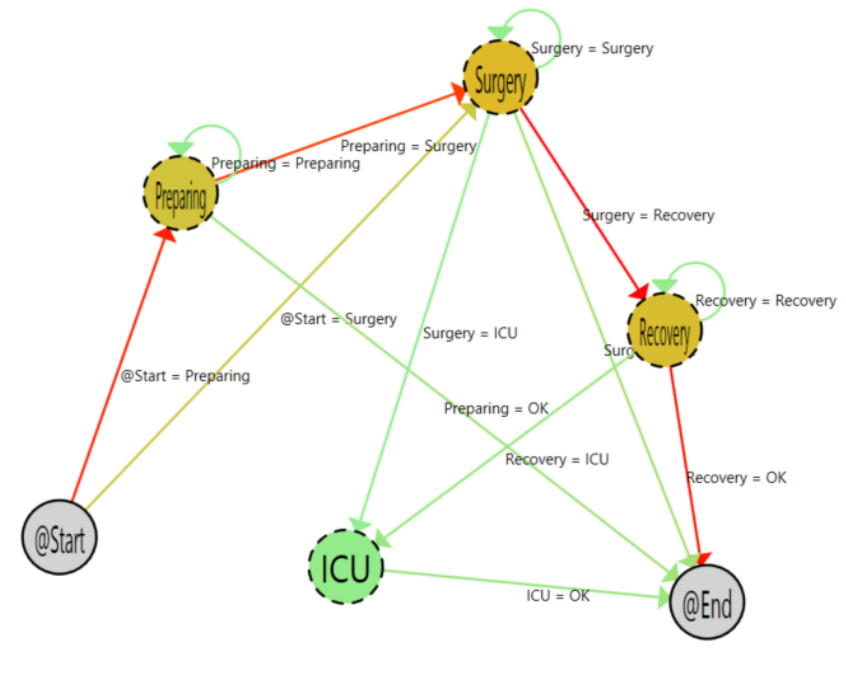
Figure 11. Hospitalized patient